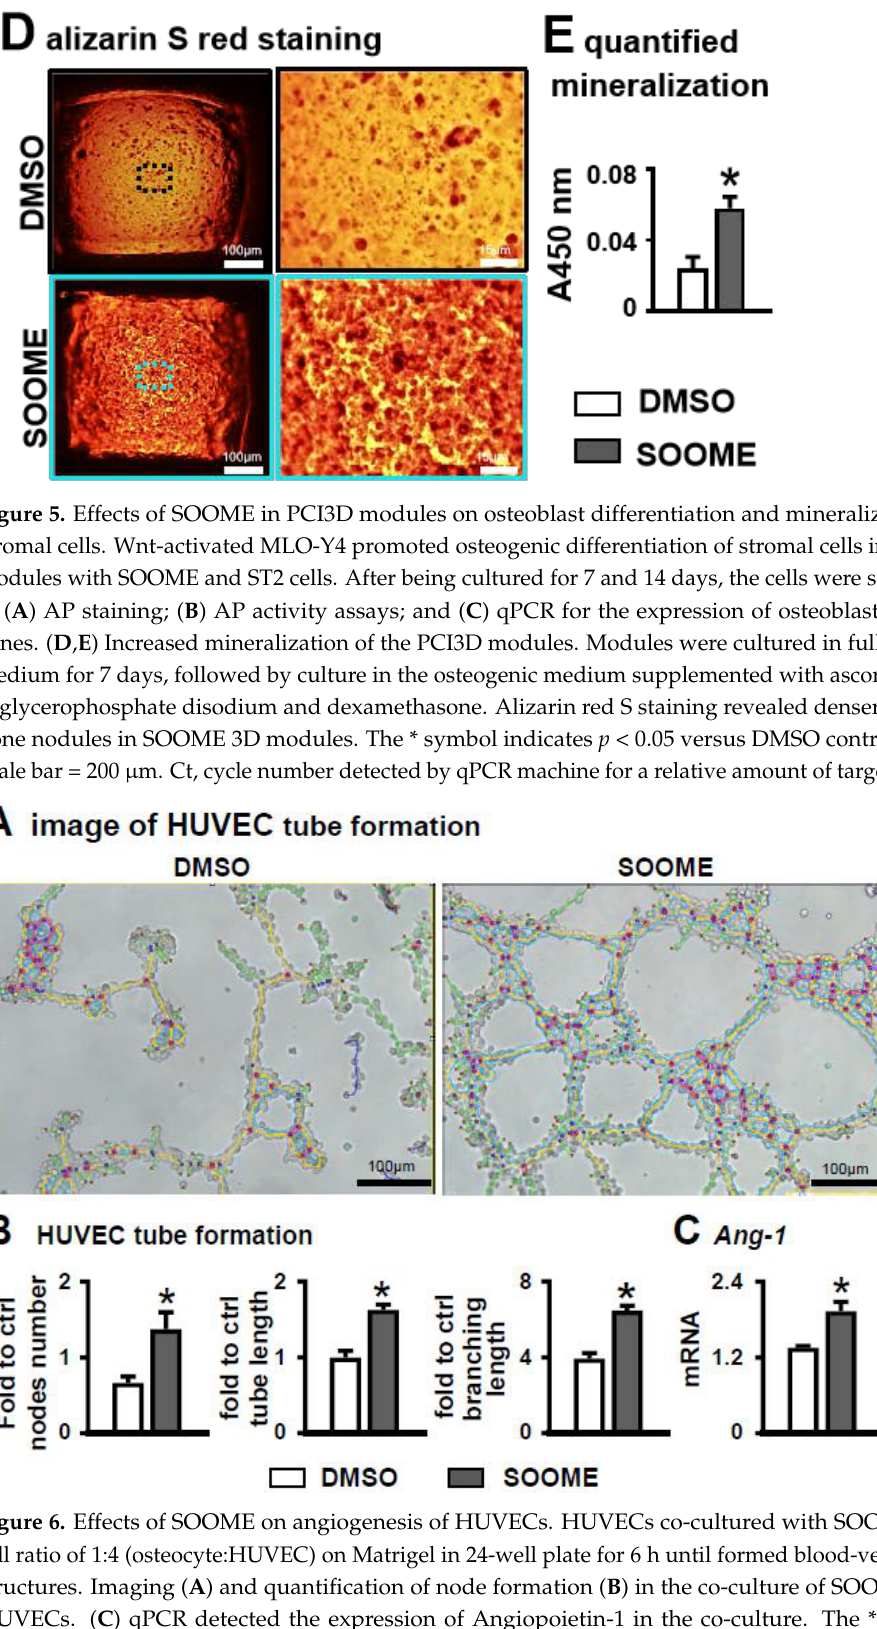
Figure 6. Effects of SOOME on angiogenesis of HUVECs. HUVECs co-cultured with SOOME at a cell ratio of 1:4 (osteocyte:HUVEC) on Matrigel in 24-well plate for 6 h until formed blood-vessel-like structures. Imaging ( A ) and quantification of node formation ( B ) in the co-culture of SOOME and HUVECs. ( C ) qPCR detected the expression of Angiopoietin-1 in the co-culture. The * symbol indicates p < 0.05 versus DMSO control; n = 3. Scale bar = 100 µm. Green = branches; orange = master segments; blue sky = meshes; red surrounded by blue = nodes; Ct, cycle number detected by qPCR machine for a relative amount of target genes.